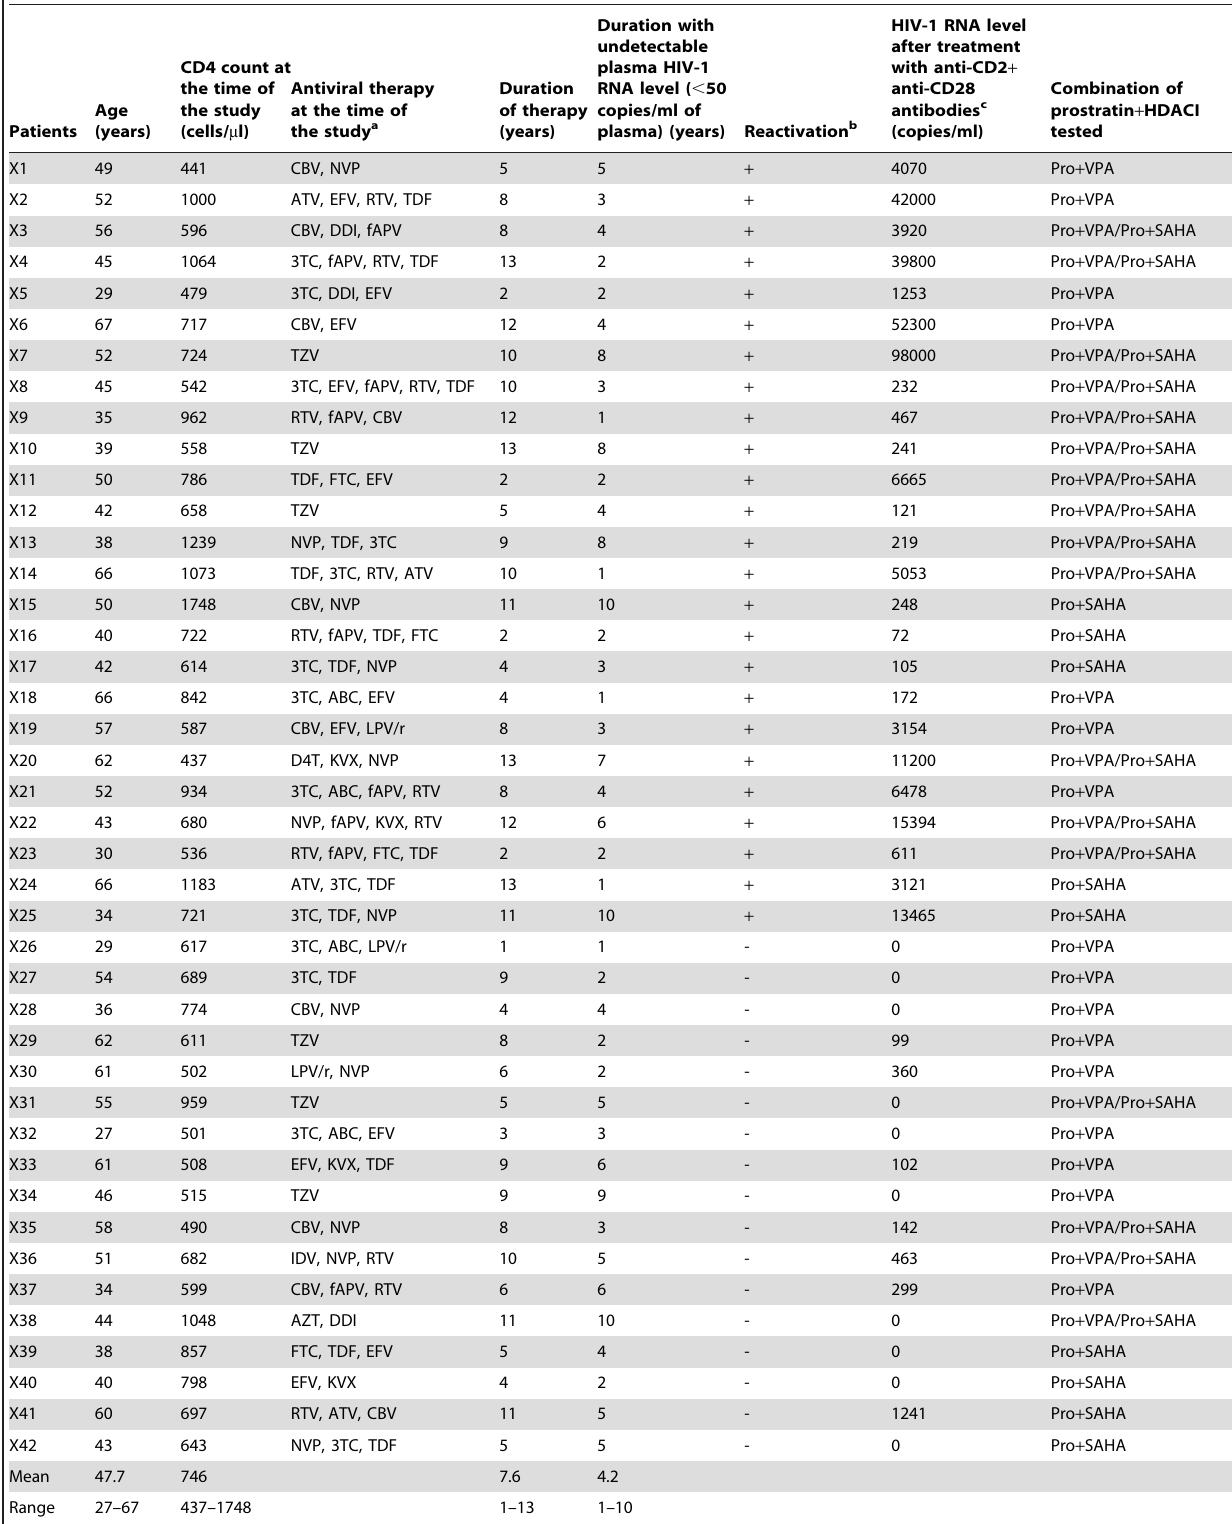
Table 1. Characteristics of HIV-1-infected individuals named X1 to X42.